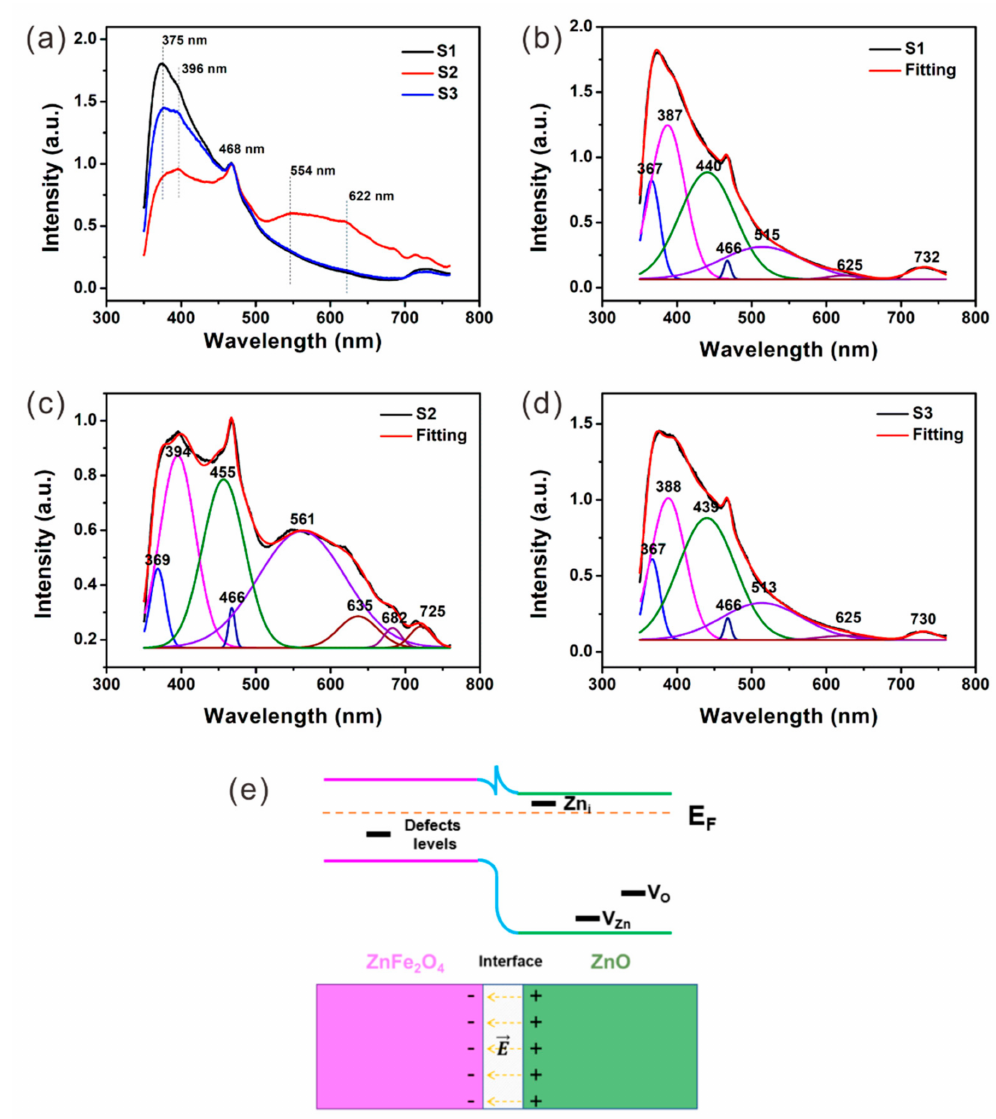
Figure 3. ( a ) PL spectra of S1–S3; Gaussian fitting of PL spectrum of ( b ) S1, ( c ) S2 and ( d ) S3; ( e ) energy band diagram and schematic diagram of ZnFe 2 O 4 /ZnO